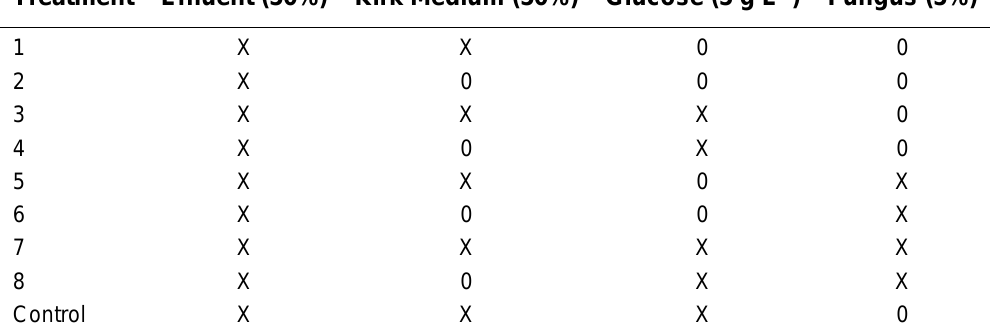
Treatments and Control for the Decolorization of a Textile Effluent in a Liquid Medium with CDBB-H-1051 Tv Ligninolytic Fungus, where 0 = Without; X =